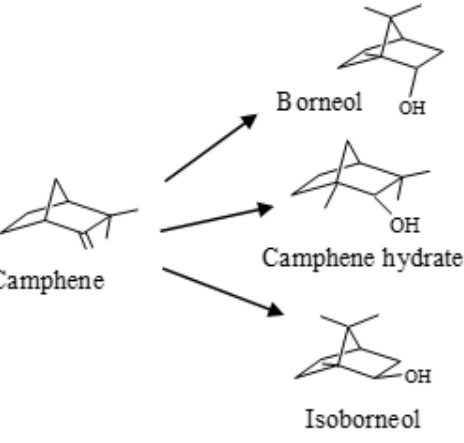
Figure 1. Scheme of camphene hydration.